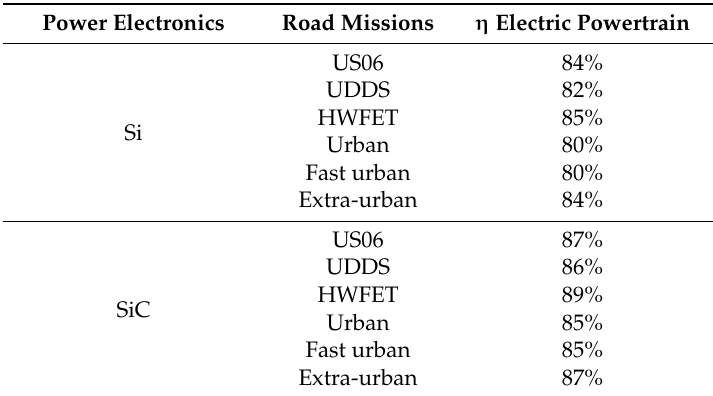
Table 7. Electric powertrain efficiency over different road missions.